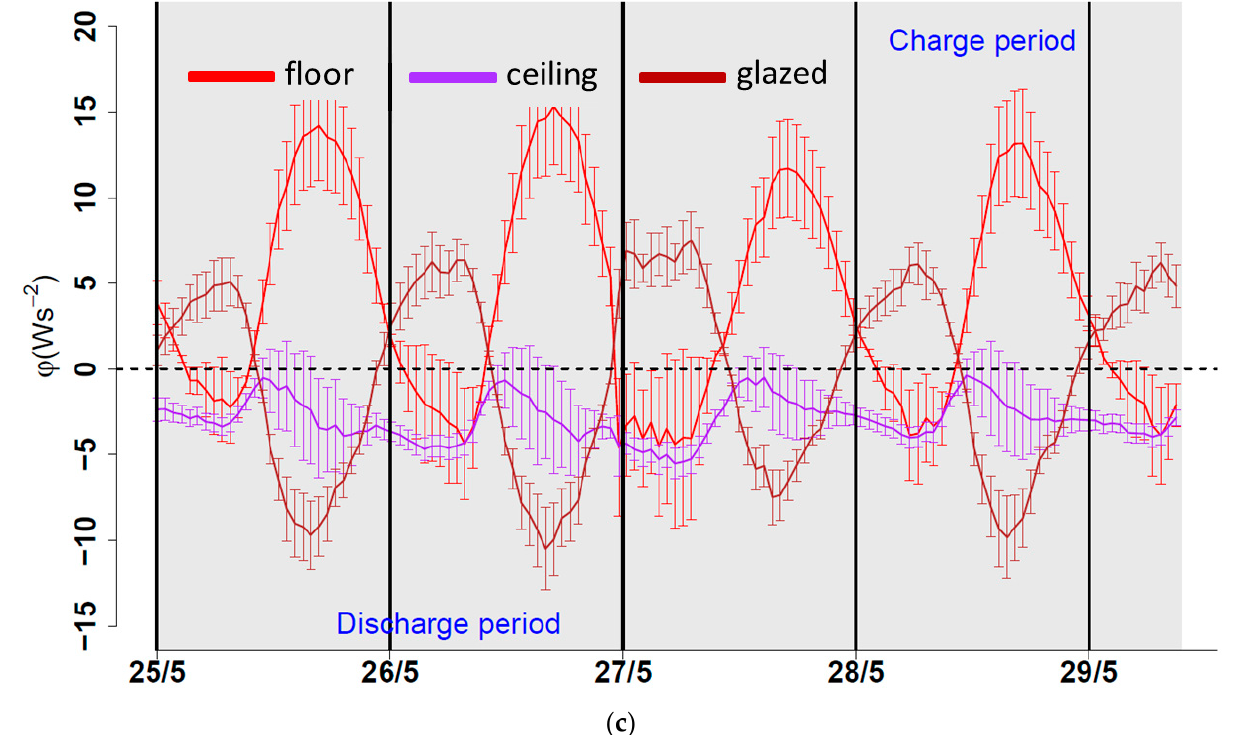
Figure 8. Radiative heat flux for: ( a ) config. #1, ( b ) config. #2, and ( c ) config. #3. Table 7. Contribution of different surfaces to the indoor air based on convective heat flux.